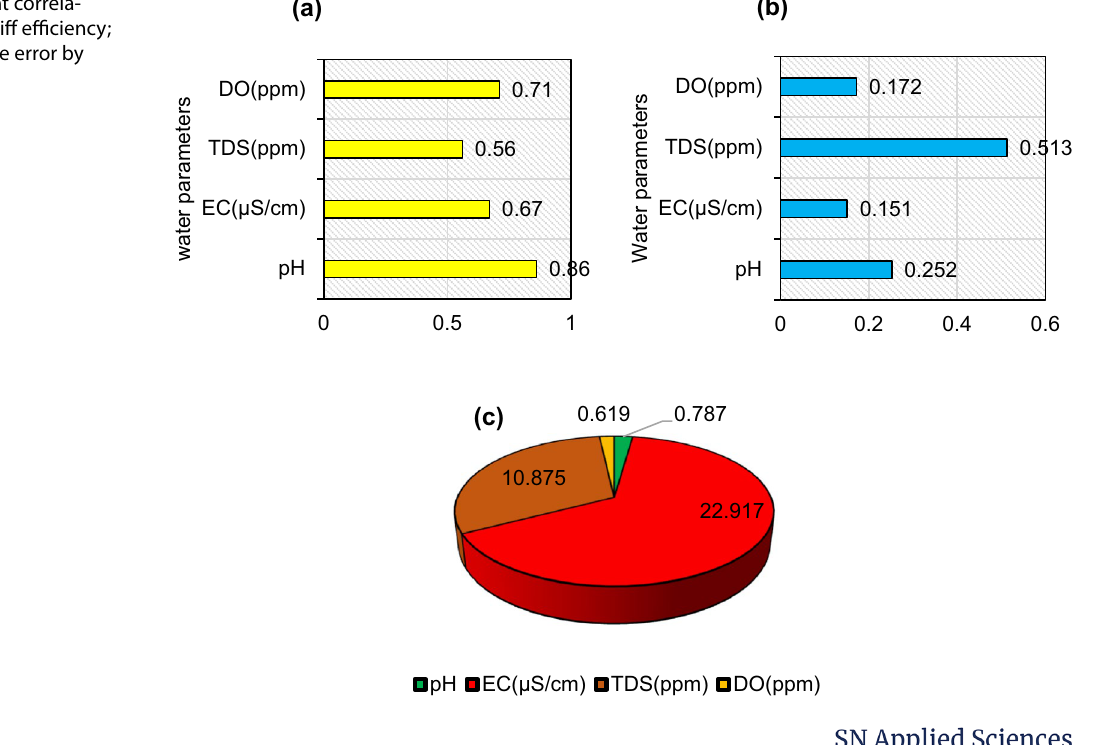
Fig. 5 a Coefficient correla- tion; b Nash–Sutcliff efficiency; c root mean square error by ANFIS